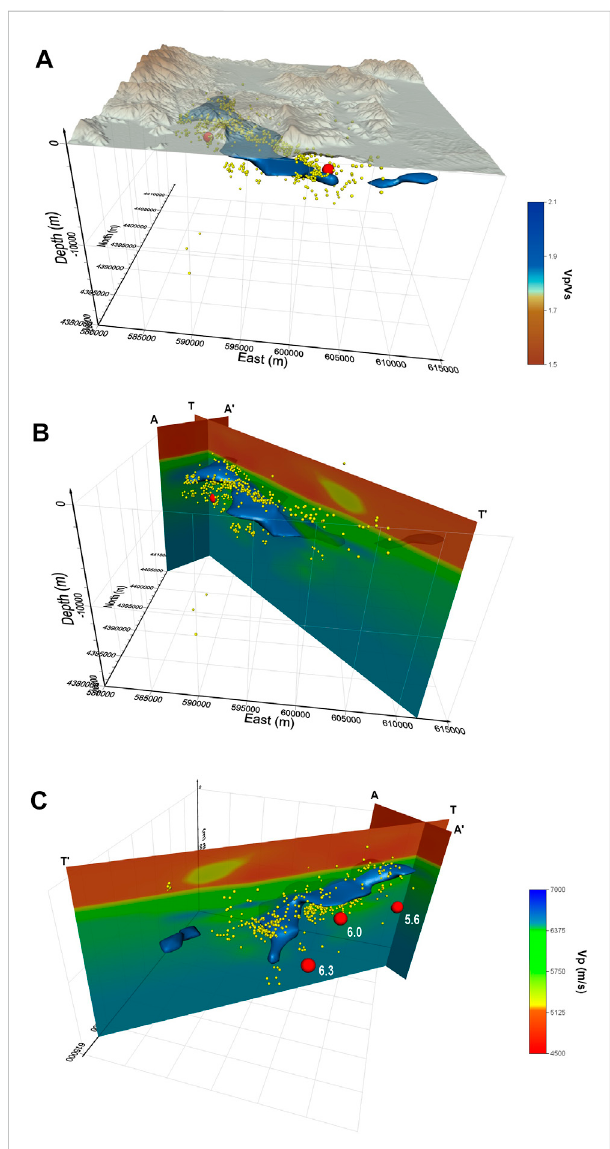
FIGURE 5 3D high V P /V S anomaly ( > 1.85), relocated seismicity (yellow spheres) and mainshocks hypocenters (red spheres), in (A) topped by the topography of Northern Thessaly area; in (B) and (C) shown with the addition of V P cross-sections (AA ’ and TT ’ ) from two different view angles. V P increases at 4 km depth, showing the basal detachment that accommodates the overlying Pelagonian nappe onto the carbonatic Gavrovo